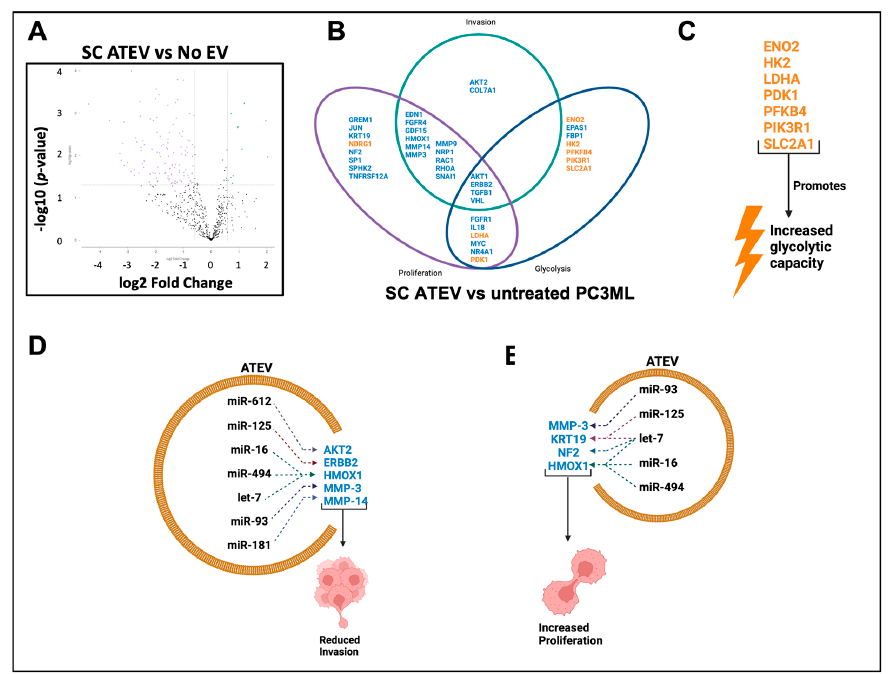
* Mean values represent normalized data from three biological replicates.